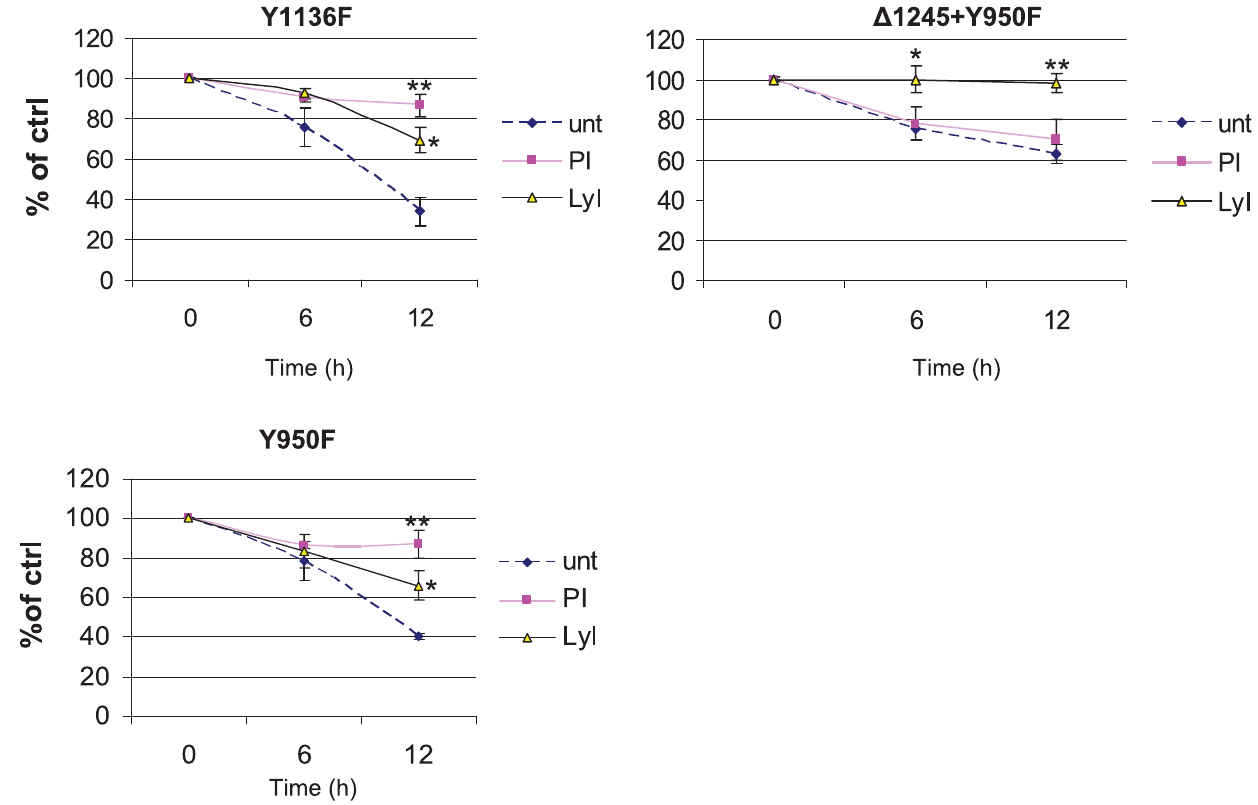
Figure 6. Intact Y1136 and Y950 are important for lysosomal degradation of IGF-1R. Y1136F, Y959F, and Y950F- D 1245 cells were pre-incubated without or with PI or LyI and treated with CHX as described in Fig. 5. After western blotting quantification of IGF-1R, as normalized with GAPDH, was performed. Means and SDs of three different experiments are shown. *P, , 0.05 ; ** P, , 0.005 .